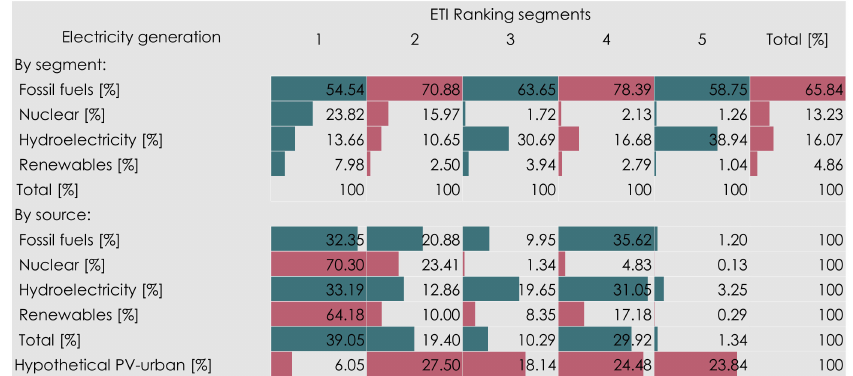
Figure 10. Share of the electricity generation mix and share with urban PV (Photovoltaic) generation by ETI ranking segments 2017. Note: Renewables—biomass and waste, geothermal, solar, tide, and wave electricity, and